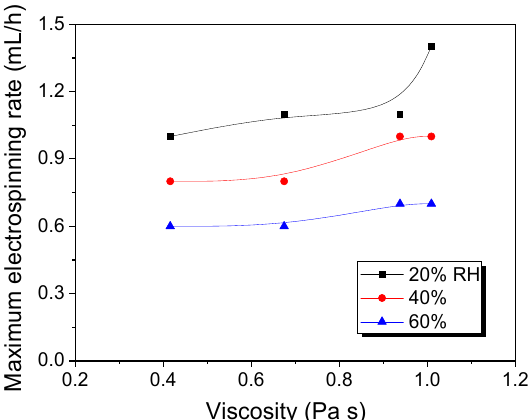
Figure 1. Effect of relative humidity on the maximum electrospinning rate of regenerated silk formic acid solutions with different silk concentrations.